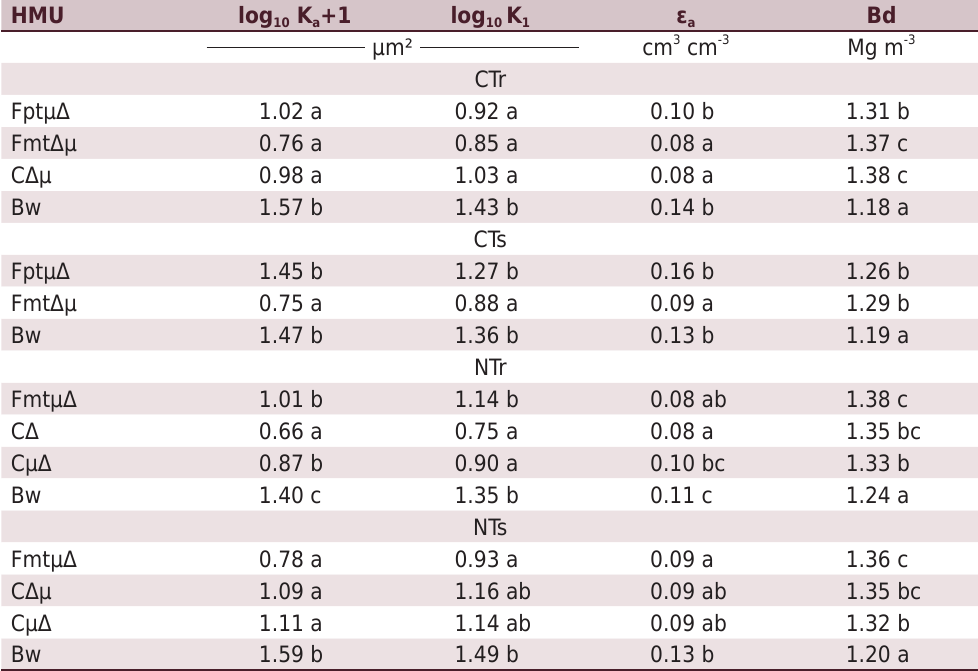
Table 2. Mean values for air permeability (K a ), pore continuity index (K 1 ), aeration capacity (ɛa), and bulk density (Bd) in different homogeneous morphological units (HMU) in a Ferralsol under conventional tillage (CT) and no-tillage (NT) with crop rotation (r) and succession (s)